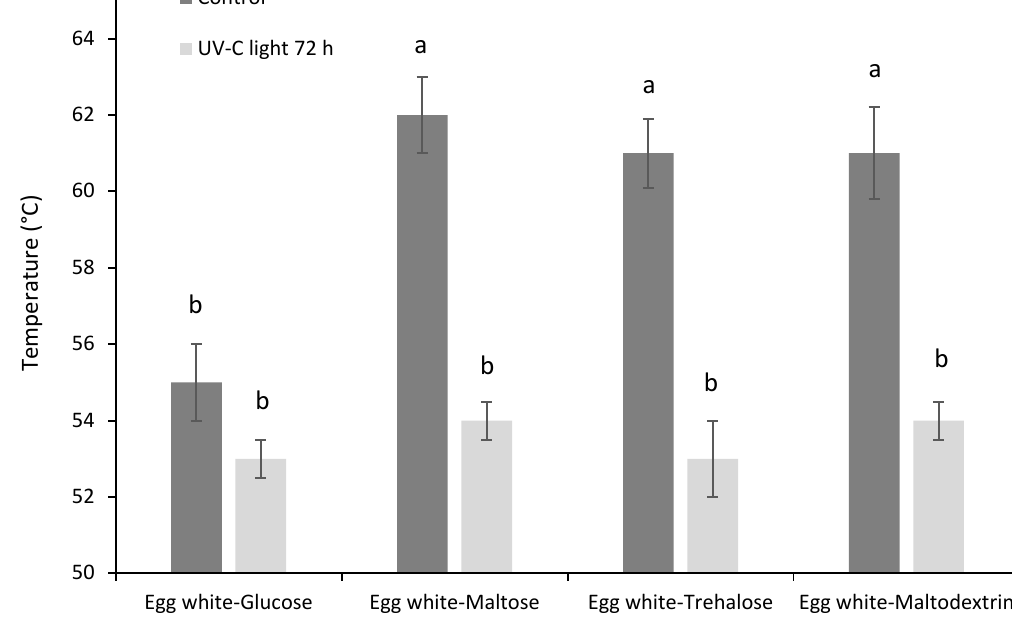
Figure 1. Apparent viscosity of aqueous suspensions of egg white and egg white–sugar mixtures before and after expo- sure to UV-C light for 72 h. a–d : Means indicated by different letters are significantly different ( p < 0.05). Error bars repre- sent the Standard Deviation.